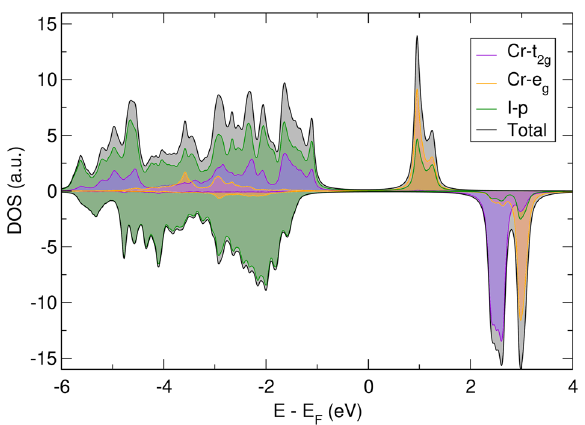
Fig. 3 Extended ( d + p )-model density of states. Green, purple, and yellow denote I p , Cr t 2 g , and e g contributions, respectively. Coulomb matrix elements from Table 3 are used.